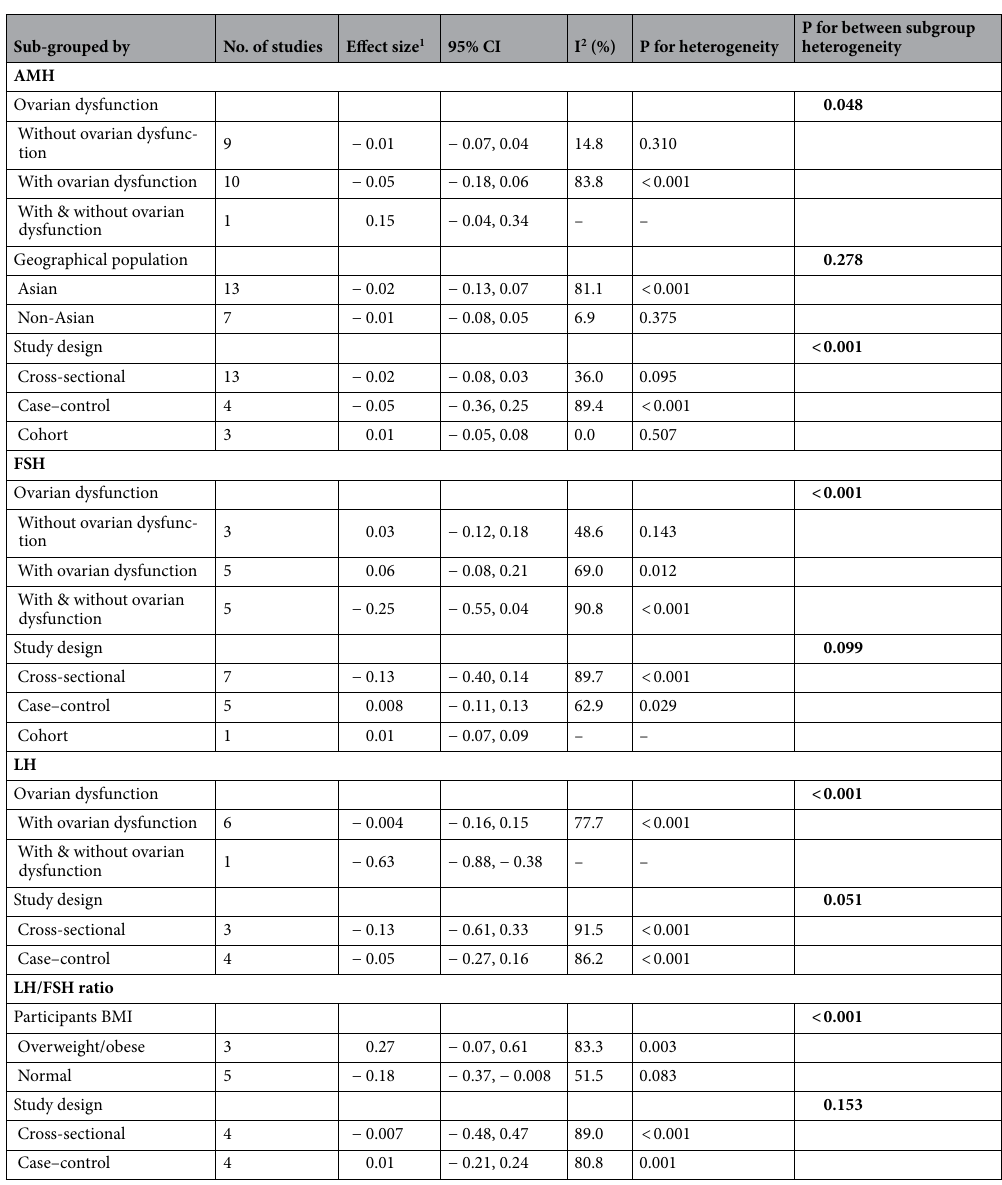
Table 3. Subgroup analysis of the correlation between ovarian reserve markers and 25(OH)D level. AMH anti-Mullerian hormone, FSH follicle stimulating hormone, LH luteinizing hormone, BMI body mass index. 1 Calculated by Random-effects model as Fisher’s